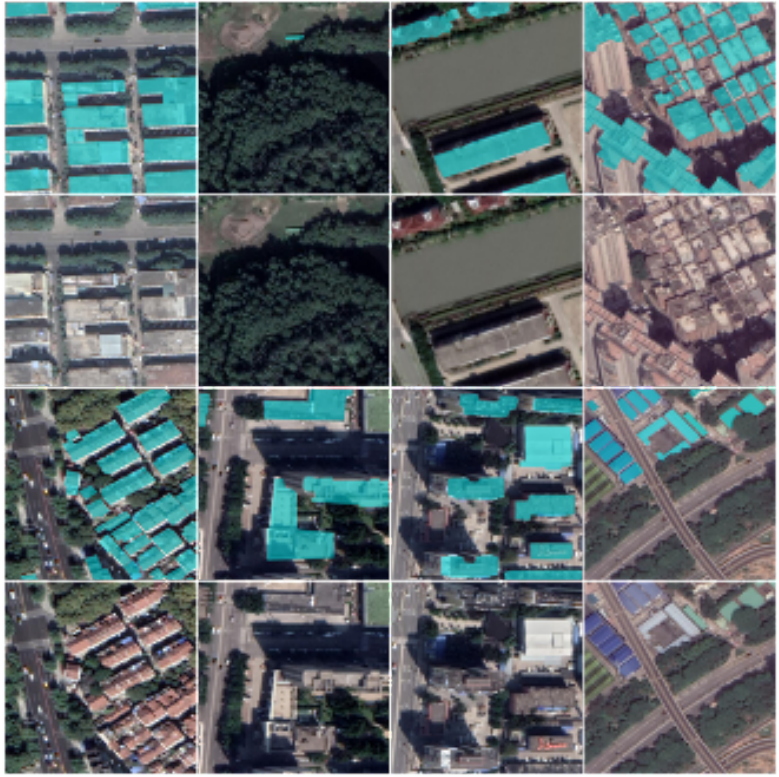
Figure 8. Samples of the self-annotated building instance segmentation dataset. The ground truth of the buildings is in